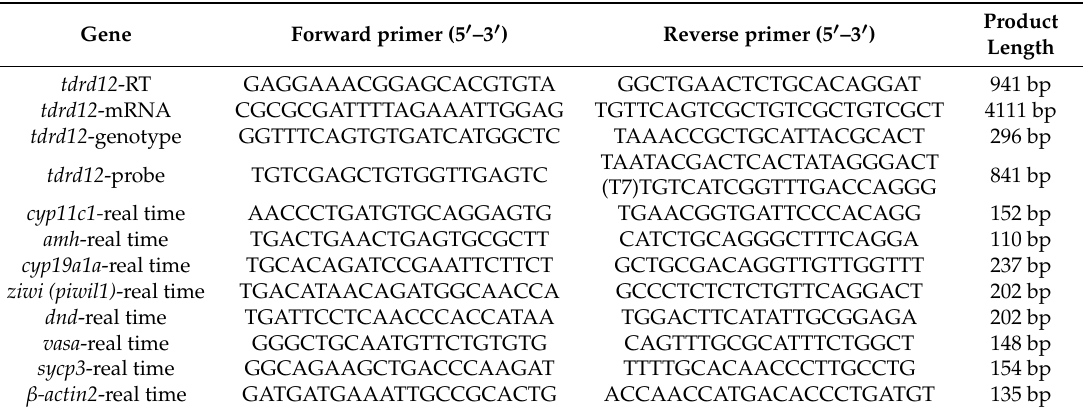
Table 1. Primers used in the